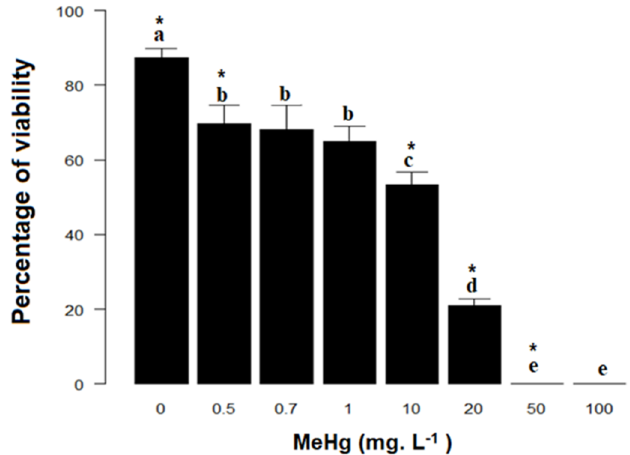
Figure 3. Cell viability of erythrocytes of loggerhead sea turtle against different concentrations of methylmercury, used for calculating lethal concentration (LC 50 ). Error bars indicate mean and standard deviation. Treatments with significant differences (ANOVA, p < 0.05) indicated by asterisk (*). Treatments with non-significant differences indicated by same letter (a, b, c, d, e).